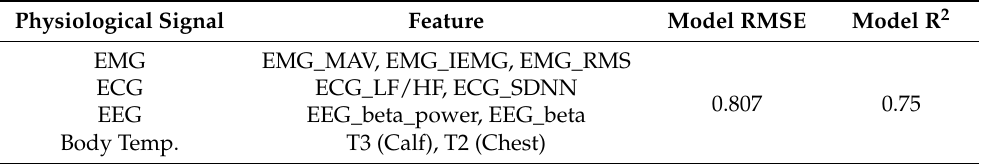
Table 3. The best performed physiological feature combination. Physiological Signal